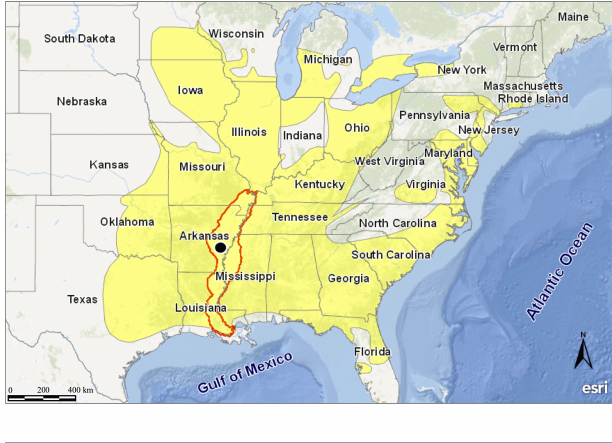
Fig. 1 . Prothonotary Warbler ( Protonotaria citrea ) breeding range (yellow), Lower Mississippi Alluvial Valley (red), and the study site in White River National Wildlife Refuge (black